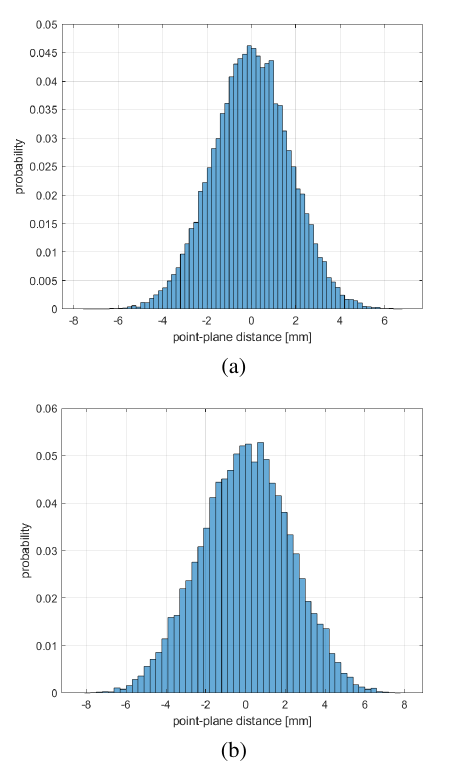
Figure 6. Histograms of point-to-plane distances for the two bricks shown in Fig.